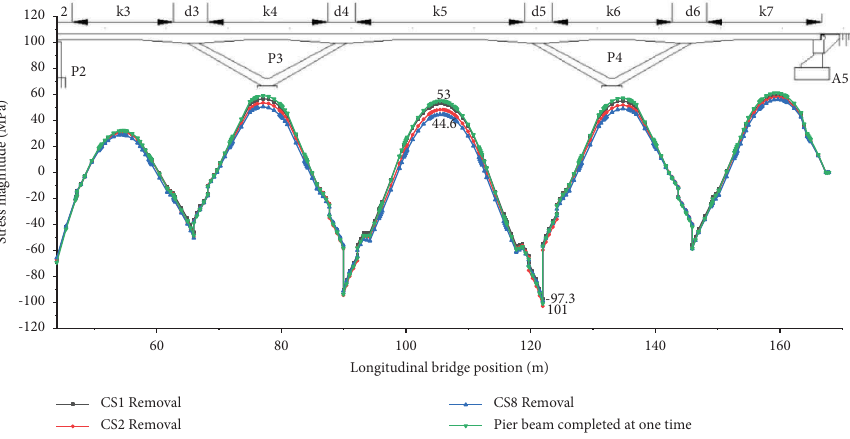
Figure 8: Stresses in lower fanges of steel beams.